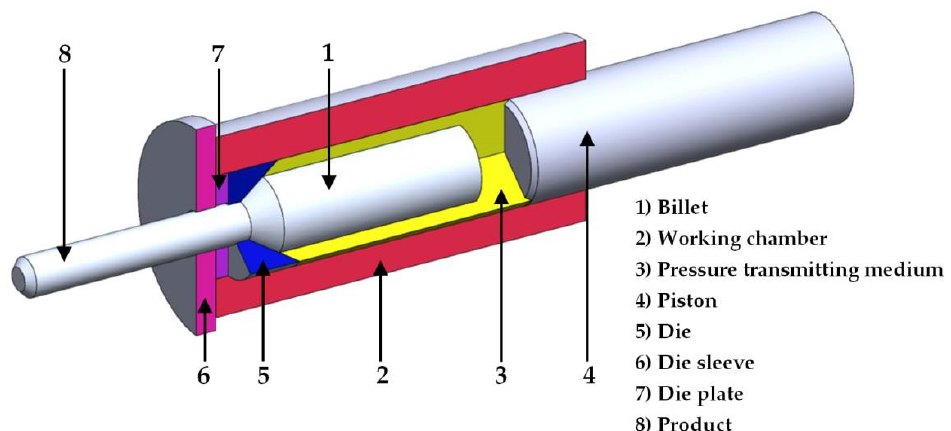
Figure 1. Scheme of the process of hydrostatic extrusion.